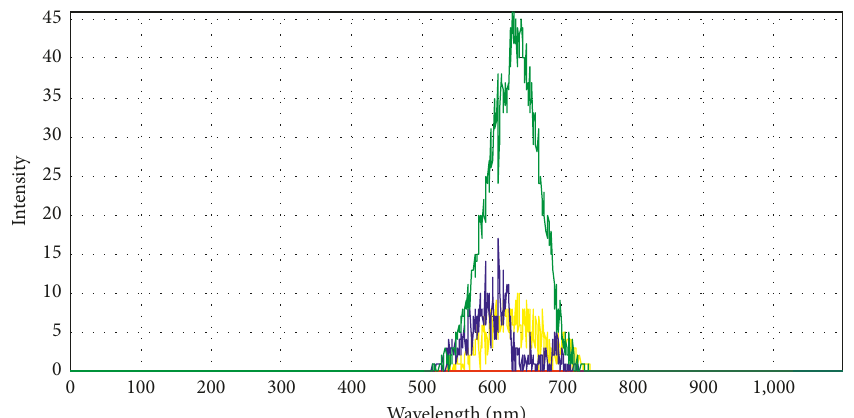
Figure 10: Screenshot of the light intensity measured during the simulation (yellow: marching rays; green: stopped rays; blue: refrac- ted/reflected rays. Vertical axis is not scaled yet).